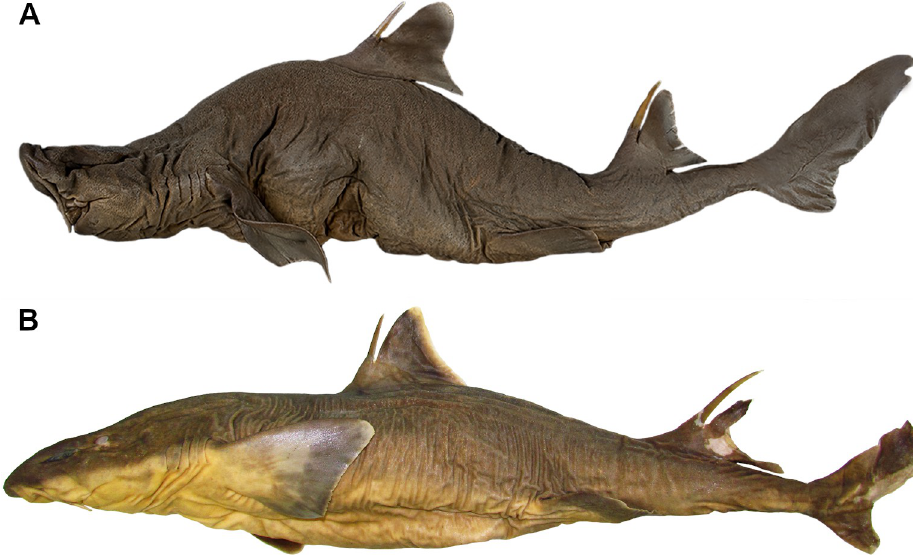
Fig 20. Specimens of C . barbifer in lateral view. A: SU 13901 (holotype of Phaenopogon barbulifer Herre, 1935), juvenile female, 730 mm TL, Japan; B: MNHN 1997–3568, adult female, 800 mm TL, New